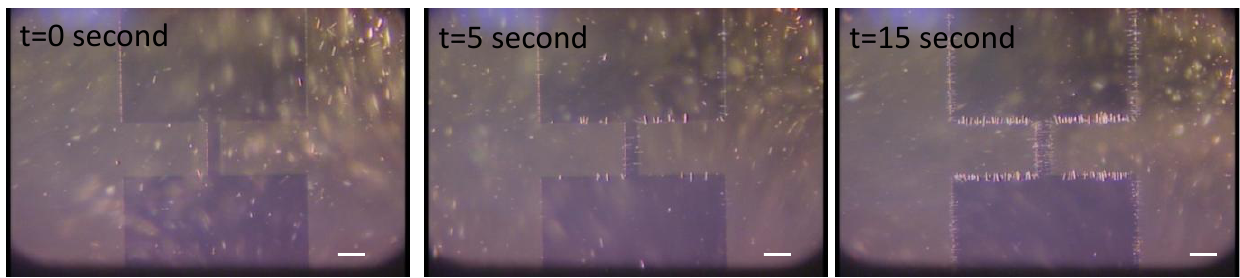
Figure 4. Sequential images of 15 µm-long nanowires deposition on the planar electrode using Dielectrophoresis. Applied voltage is 20 V scale bar is 100